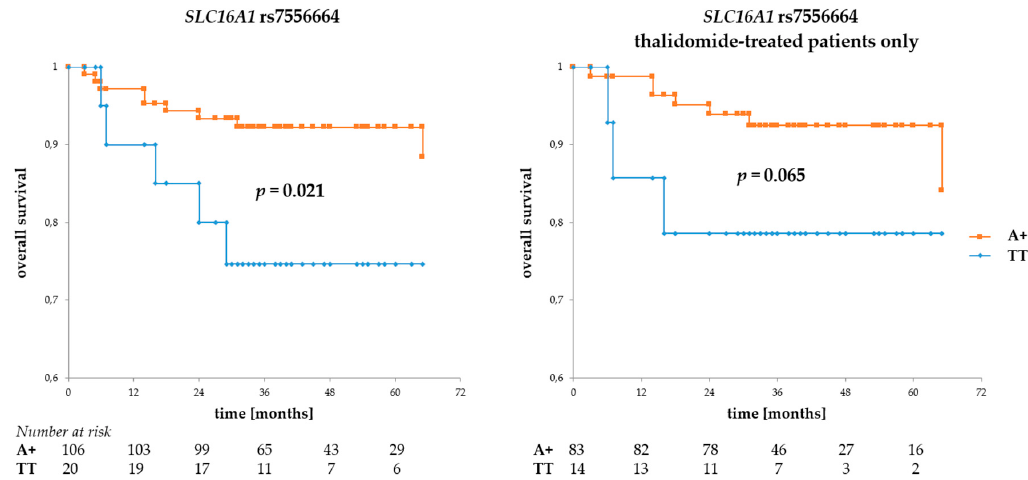
Figure 3. Overall survival in MM patients with respect to SLC16A1 rs7556664 A. This SNP is in near-perfect LD with two other SLC16A1 SNPs described in this study. Allele rs7556664 A (orange curve) also corresponds to rs1049434 A and rs7169 T; however, for the sake of simplicity, only rs7556664 A is shown in the figure above. The left panel shows OS calculated for the entire group of patients, while that to the right shows overall survival (OS) calculated for thalidomide-treated patients only. The numbers at risk show numbers of patients in the risk set (i.e., patients still living, a number used to calculate survival) at a given time point on the x -axis. Survival was calculated using the Kaplan-Meier method and the real statistics resource pack for Microsoft excel.